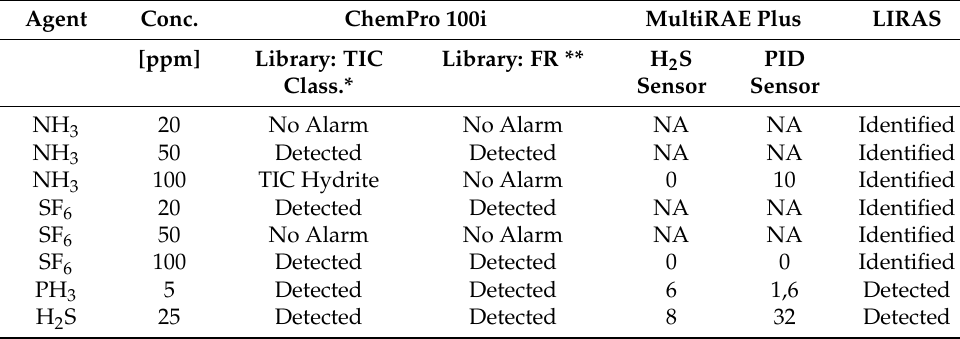
Table 8. Benchmarking of the LIRAS sensor with COTS detectors. Agent